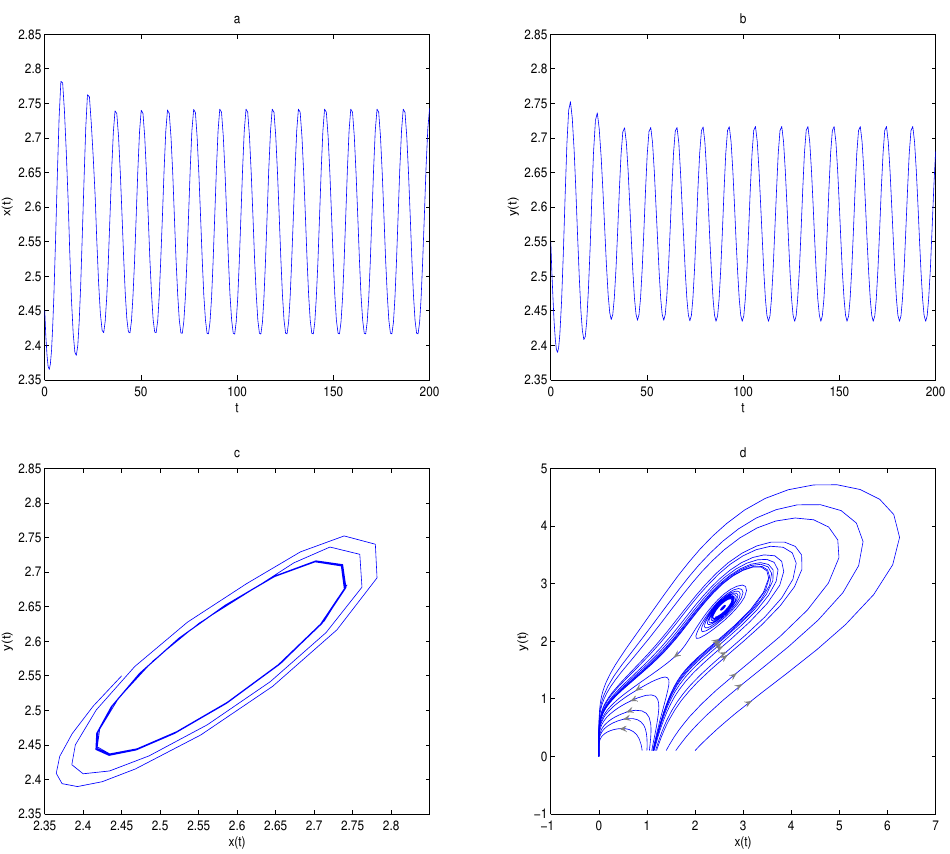
Figure 12. Subfigure ( a ) is time series of x ( t ) , subfigure ( b ) is time series of y ( t ) and subfigure ( c ) is phase diagram of system (9). O is locally stable, A 2 (1.75, 1.75) is a saddle and A 3 (2.581, 2.581) is unstable. A limit cycle is generated by Hopf supercritical bifurcarion near A 3 in subfigure ( c ), and subfigure ( d ) shows that directions of these trajectories. In here r = 2, ω = 0.414, b = 0.5, c = 2.87, α = 0.77. The initial value in subfigure ( c ) is ( x ( 0 ) , y ( 0 )) = ( 2.45,2.55 ) . The initial values in subfigure ( d ) are the same as in Figure